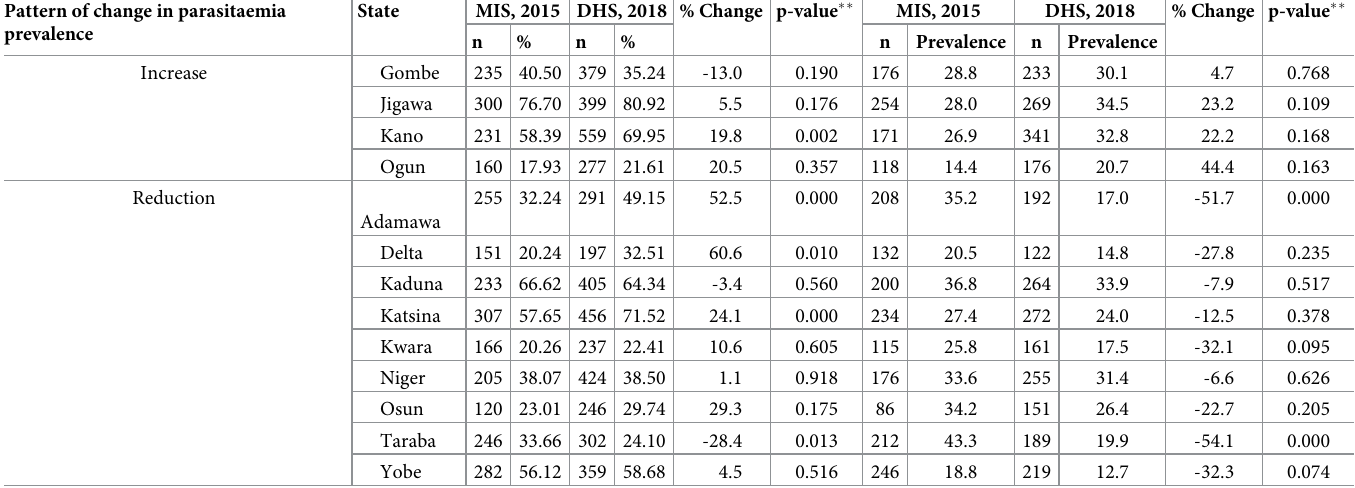
Table 4. a. LLIN utilization by survey years and percentage changes between 2015 and 2018 in 13 Nigeria States. b. Parasitaemia prevalence and percentage changes between 2015 and 2018 in 13 Nigeria States. Pattern of change in parasitaemia State prevalence Increase